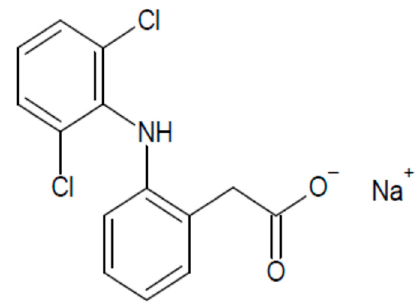
Figure 1. Chemical structure of diclofenac sodium.